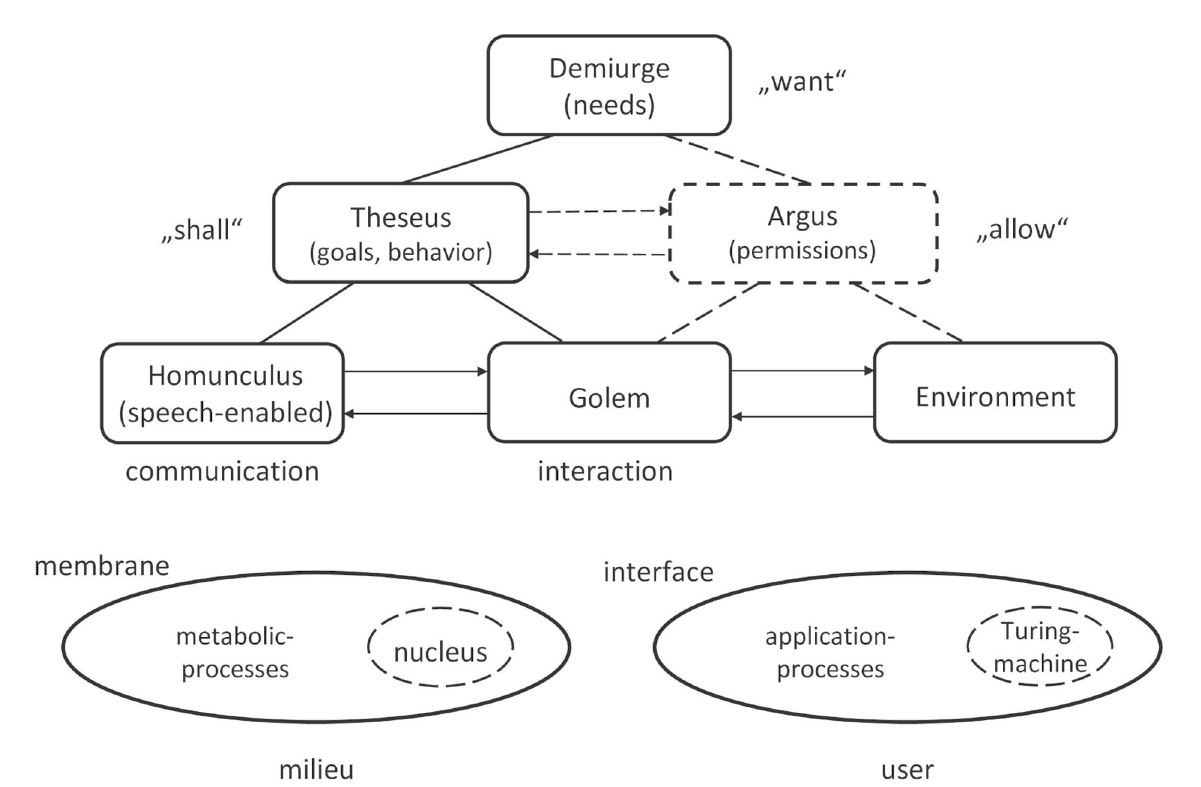
FIGURE1 Multi-Agent-System. The DAGHT-architecture results from the analysis of natural organisms (biological cells) and technical artifacts (embedded Turing Machines) as well as traditional cognitive architectures. Necessities or needs are given by a system designer (“Demiurge”), motives and goal directed behavior are implemented by the hero “Theseus”. The ability to allow permissions in terms of the interaction between the agent and the environment is associated with the “Argus” agent. The perception-action cycle controls information exchange with the environment. It is separated into interaction and communication. Interaction is within the scope of the “Golem” agent, it comprises the control of physical system components and the assessment of target objects. The “Golem” agent itself is controlled by the “Homunculus” agent which is working on representational data structures and is additionally